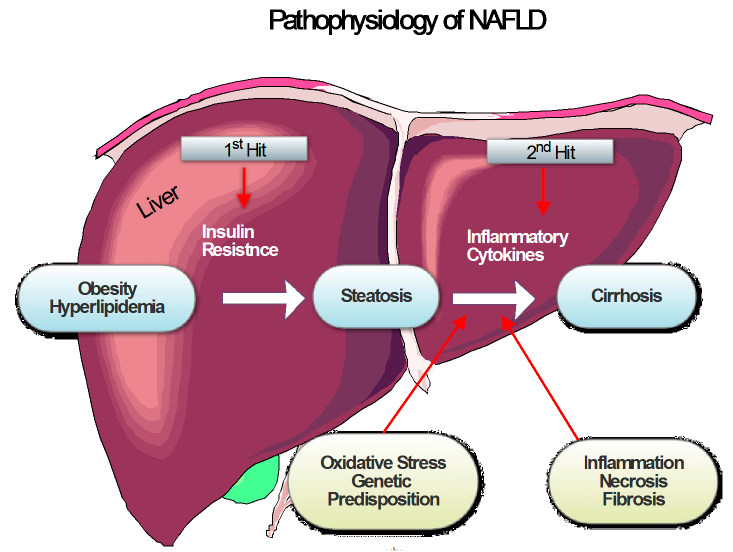
Figure 2. Pathophysiology of nonalcoholic fatty liver disease (NAFLD). The pathogenesis can be explained by the “two hit” hypothesis, and the different grades of severity are indicated by the white arrow. Various factors are involved in the development of NAFLD and represented by the red